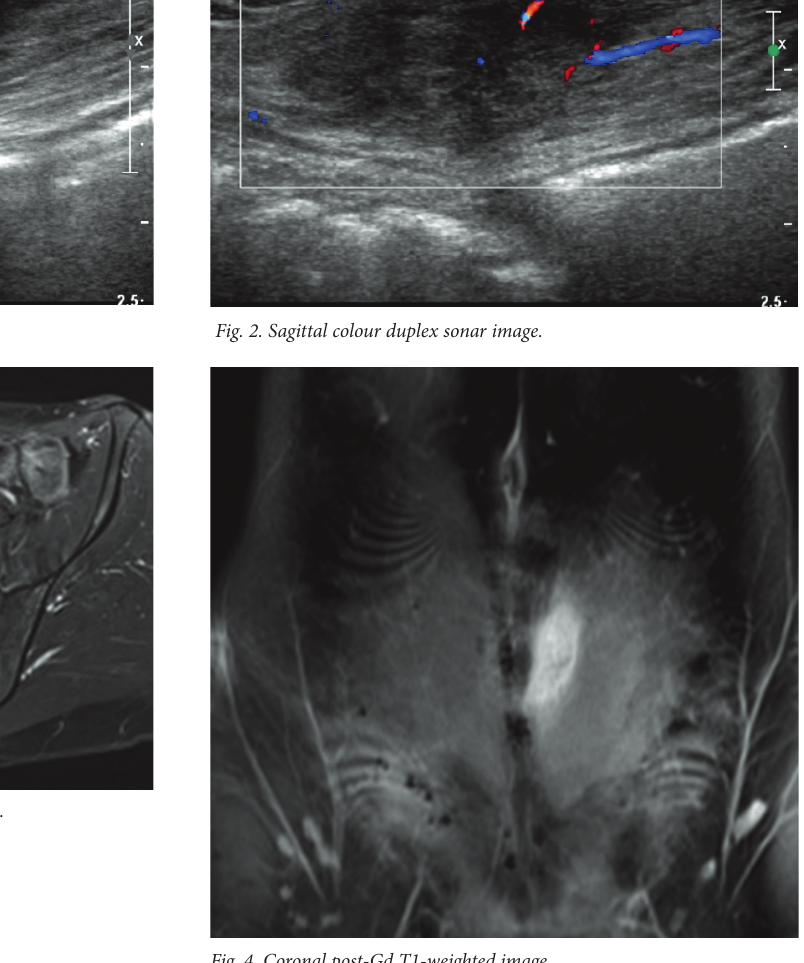
Fig. 4. Coronal post-Gd T1-weighted